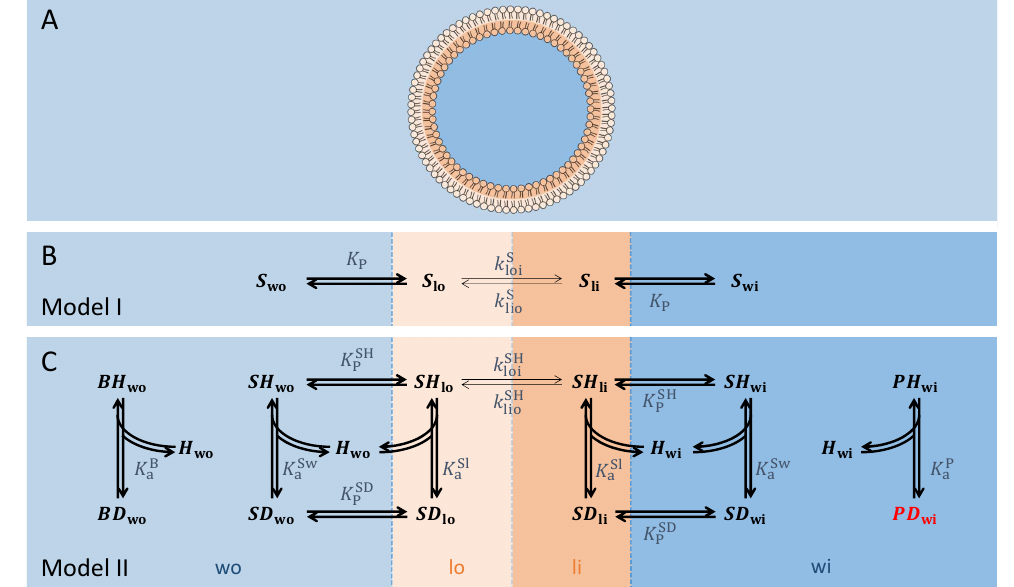
Figure 1. ( A ) Schematic representation of a liposome and the four distinct compartments. The outer aqueous compartment is represented in light blue, the outer membrane leaflet in light orange, the inner membrane leaflet in orange and the inner aqueous compartment in blue. ( B ) Reaction scheme for the permeation of a non-ionisable solute (Model I). The translocation between the membrane leaflets is the rate-limiting step (thin arrows), with the aqueous/membrane partition being at quasi- equilibrium (thick arrows). ( C ) Reaction scheme for the permeation of a weak acid (Model II). The translocation between the membrane leaflets is the single rate-limiting step (thin arrows), with protonation/deprotonation and aqueous/membrane partition processes being at quasi-equilibrium (thick